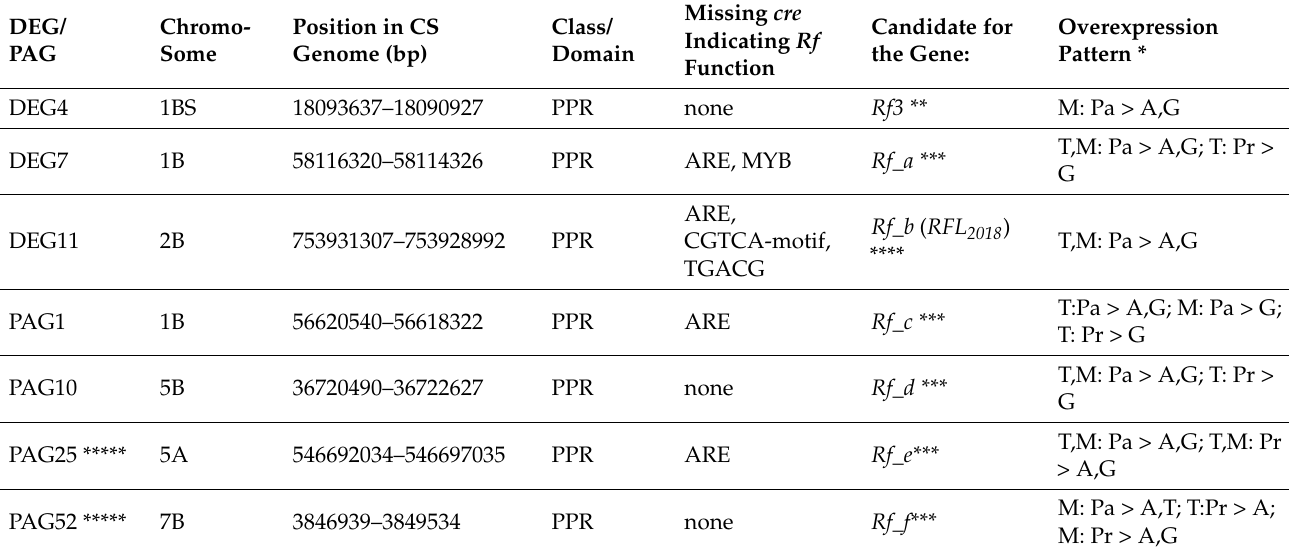
Table 3. Probable Rf candidate genes among the DEGs and